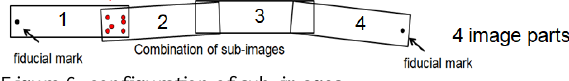
Figure 2. Basic principle of CORONA camera